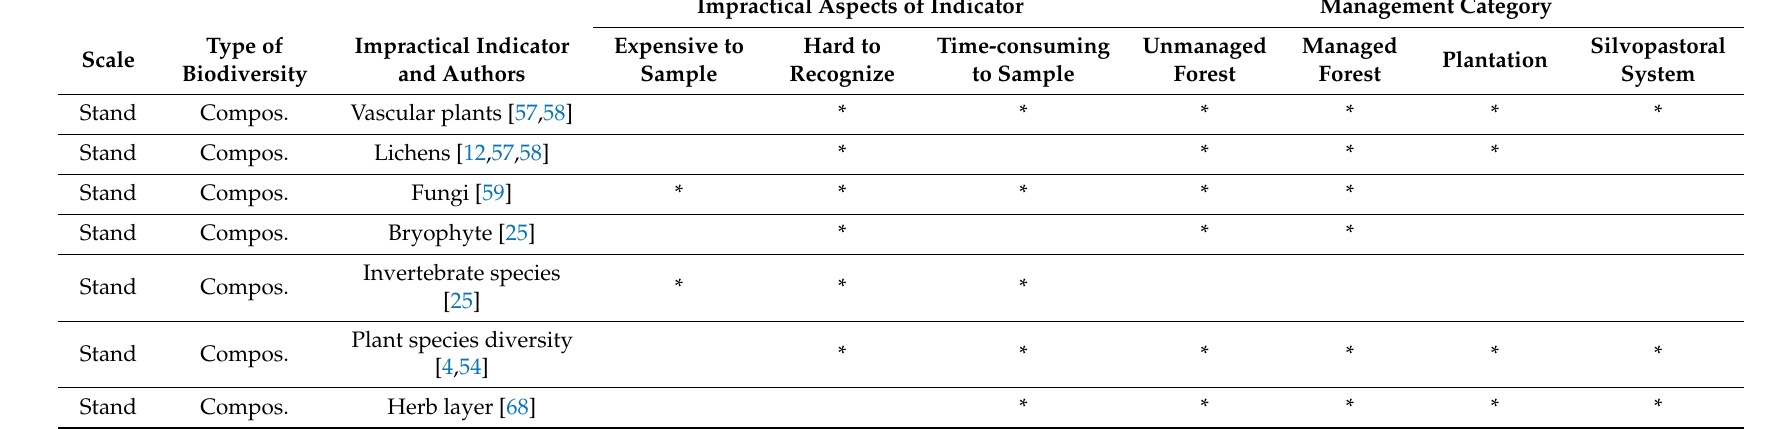
Table 2. Impractical indicators for various management categories at stand scale reported in the literature (* indicates the property) . Note that we did not identify impractical landscape scale